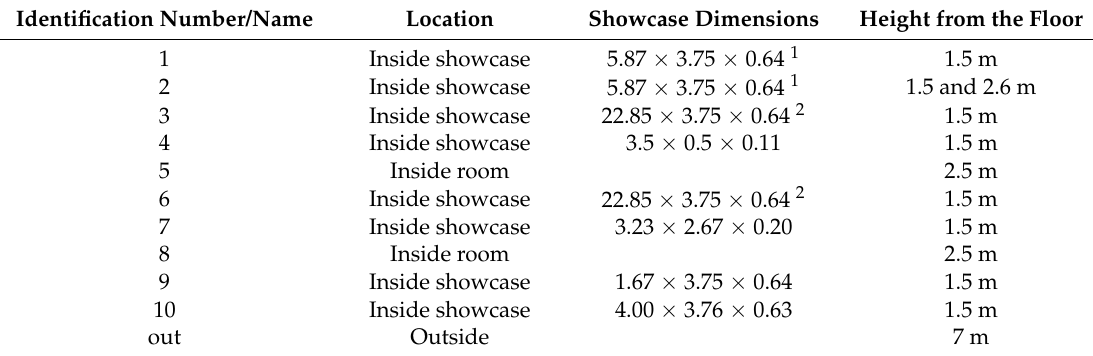
Table 2. Data collection